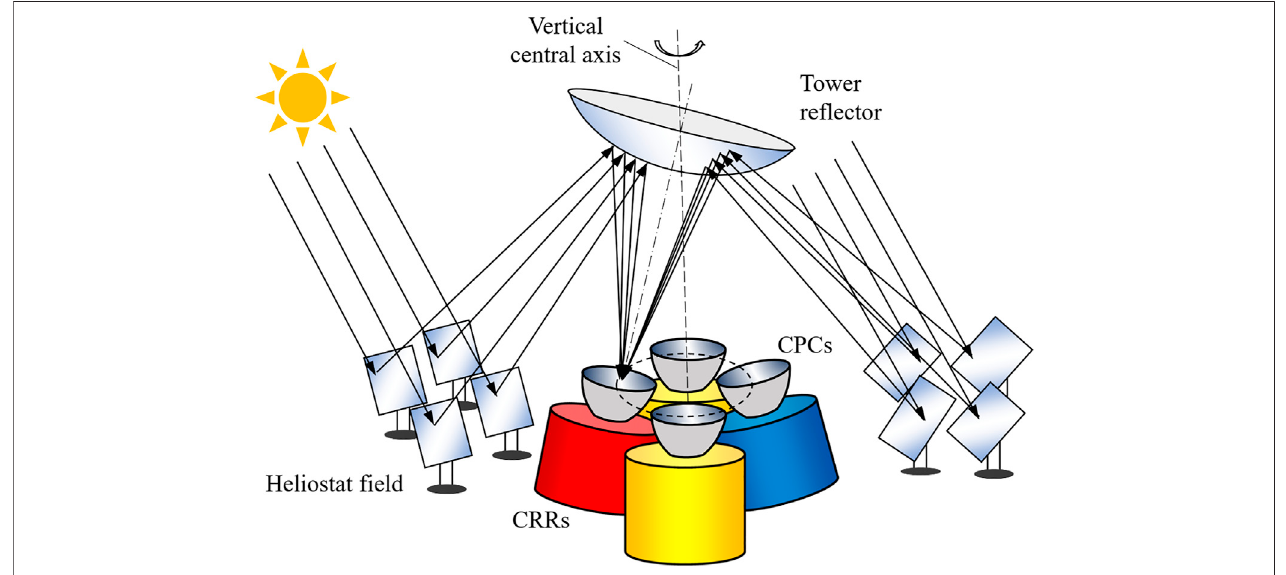
FIGURE1| Schematicoftheproposedsolarthermochemicalsystemconsistingofaheliostat fi eld,abeam-downre fl ector,andacavityreceiver – reactorarray.This fi gure is adapted from (Li et al.,